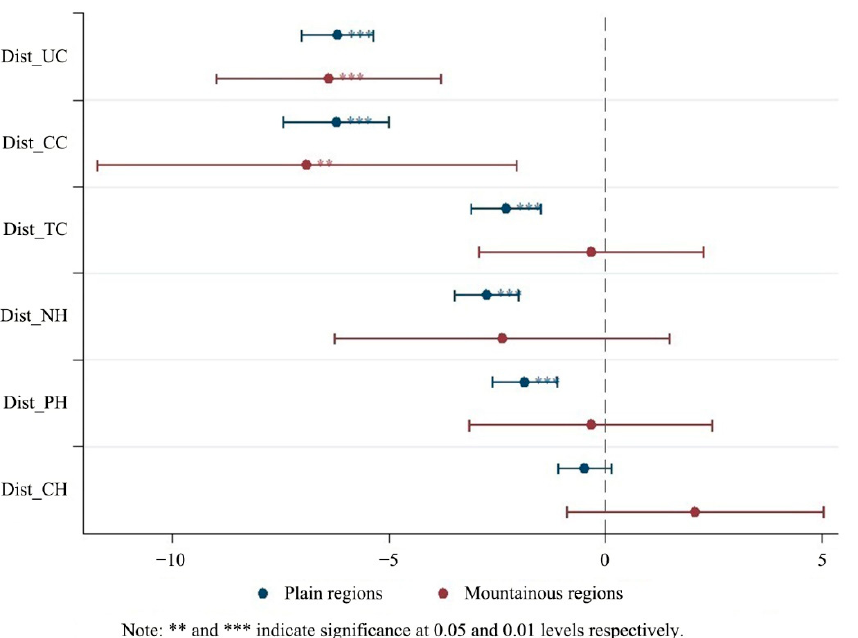
Figure 4. Coefficients of multilevel location in plains and mountainous regions.